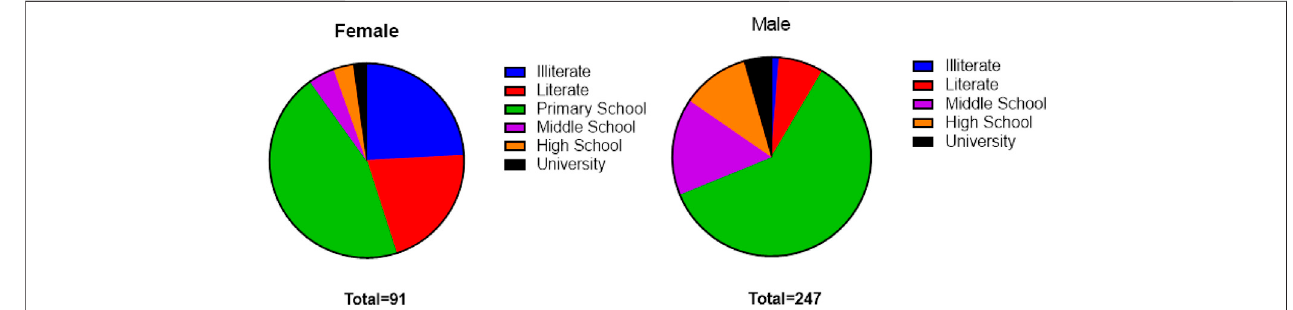
FIGURE 8 | (A – B) Educational status of